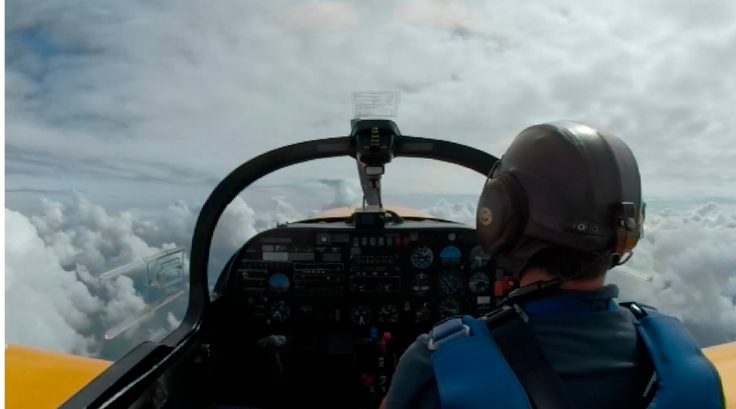
Figure 3. Front cockpit view in-flight from GoPro camera system.